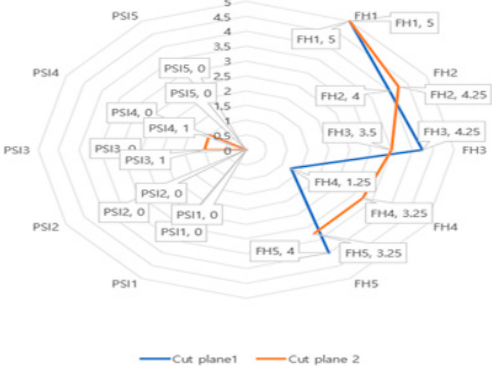
Figure 11. Distance (mm) from the target plane to the cut plane: freehand (FH) versus patient specific instrument (PSI). The numbers on the center to the 12 o’clock direction are the indicated distances in millimeters from the cutting target position. The PSI group (left) and the FH group (right) side were placed. The results are shown separately by dividing the cut ‐ planes 1 and 2 in each text box.